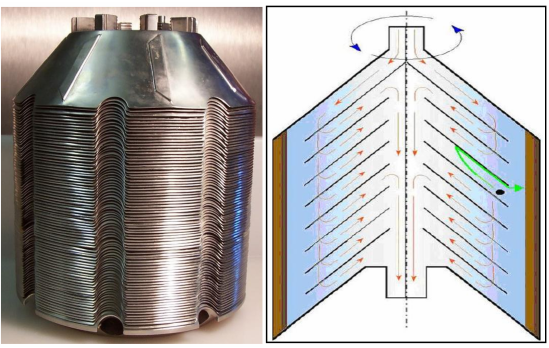
Figure 16. The disc stack in a centrifuge and the flow pattern [138].